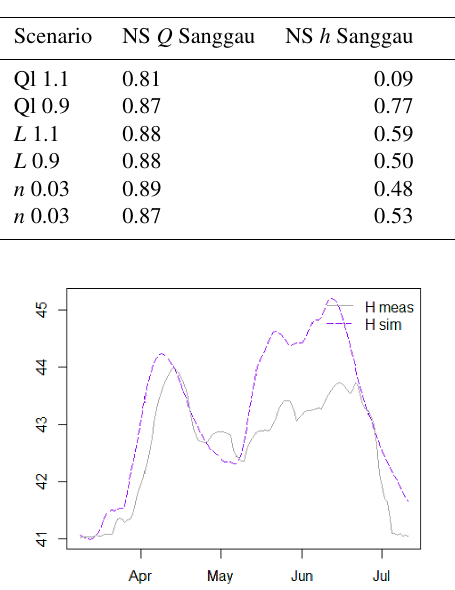
Table 2. Effects of changing lateral influx (Ql) [m 3 s − 1 ], lake stor- age/elevation ( L ) [m] and Manning’s n [sm − 1 / 3 ] on simulated wa- ter level ( h ) and discharge ( Q ) at Sanggau.